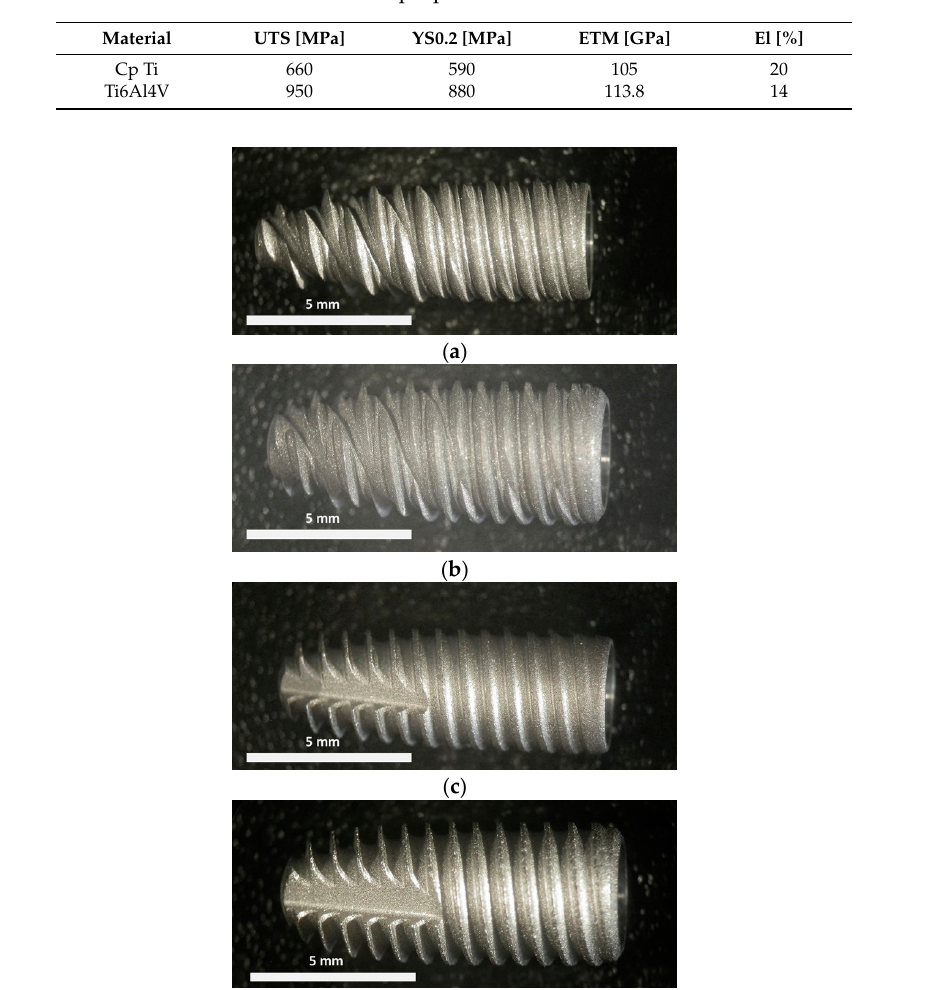
Figure 1. Macrographs of the dental implants used in this experimentation, specifically: ( a ) A, ( b ) B, ( c ) C, ( d ) D (see Table 1 for